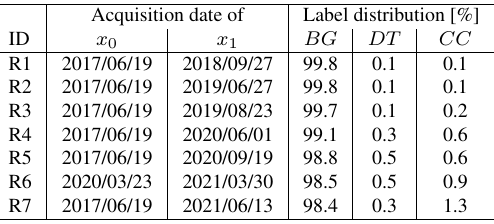
Table 3. Dates and label distributions of the reference label maps for the bi-temporal forest degradation classification. The reference maps are available for all four Sentinel-2 tiles shown in Figure